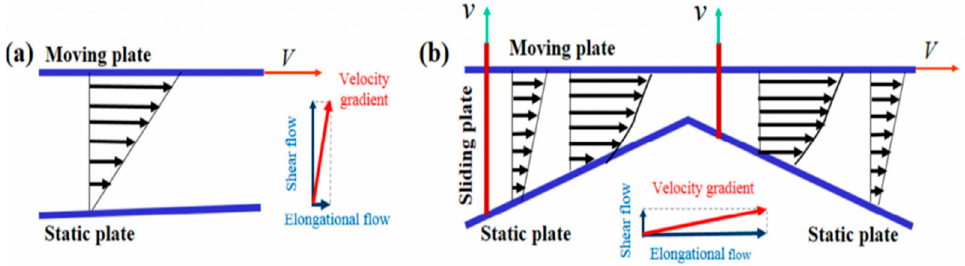
Figure 1. Schematic diagrams of ( a ) shear flow field and ( b ) elongational flow field. Reproduced under the CC BY-NC-ND license from [17].